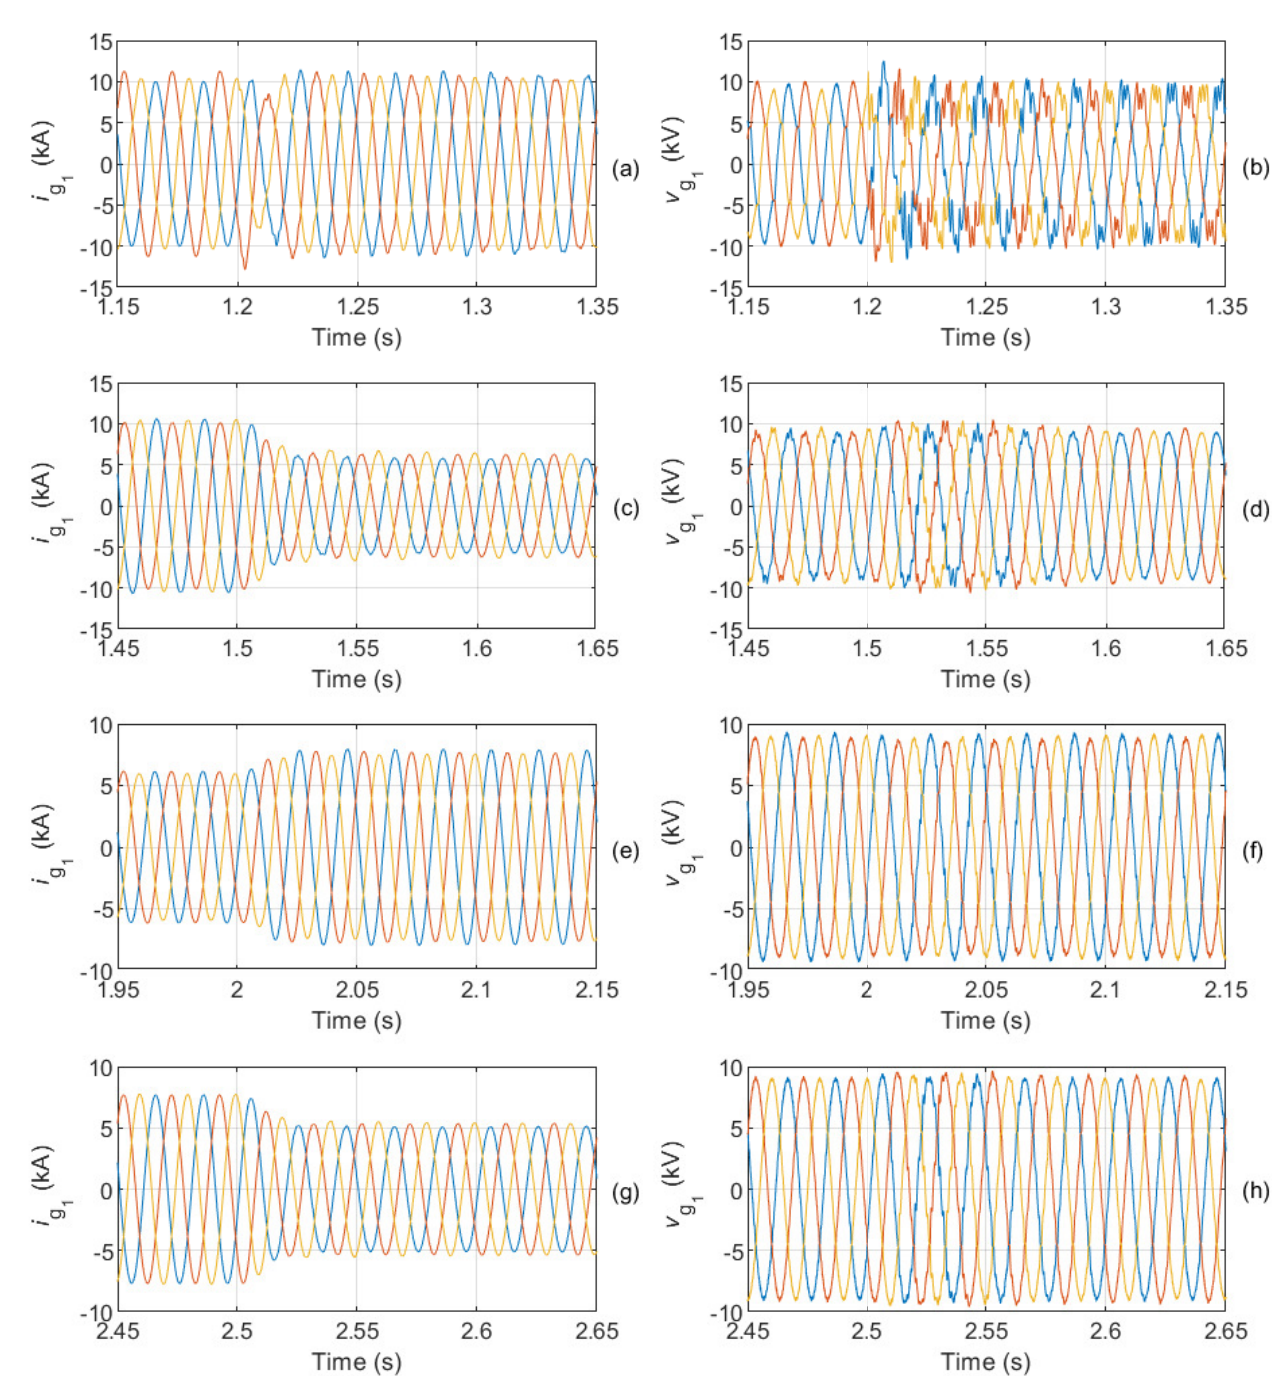
1.35 s), t ≤ ≤ 1.65 s), ( d ) line-to-neutral t ≤ ≤ 2.15 s), ( f ) line-to-neutral voltages at PCC 1 t ≤ ≤ 2.65 t ≤ ≤